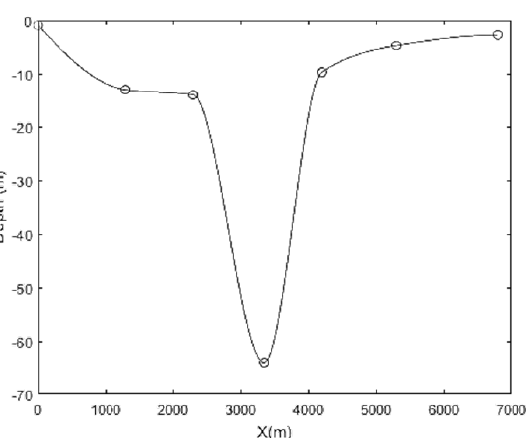
Fig. 6. Assumed yearly time series of the current velocity (m/s) at water surface (based on trend data (2004) for another similar site,